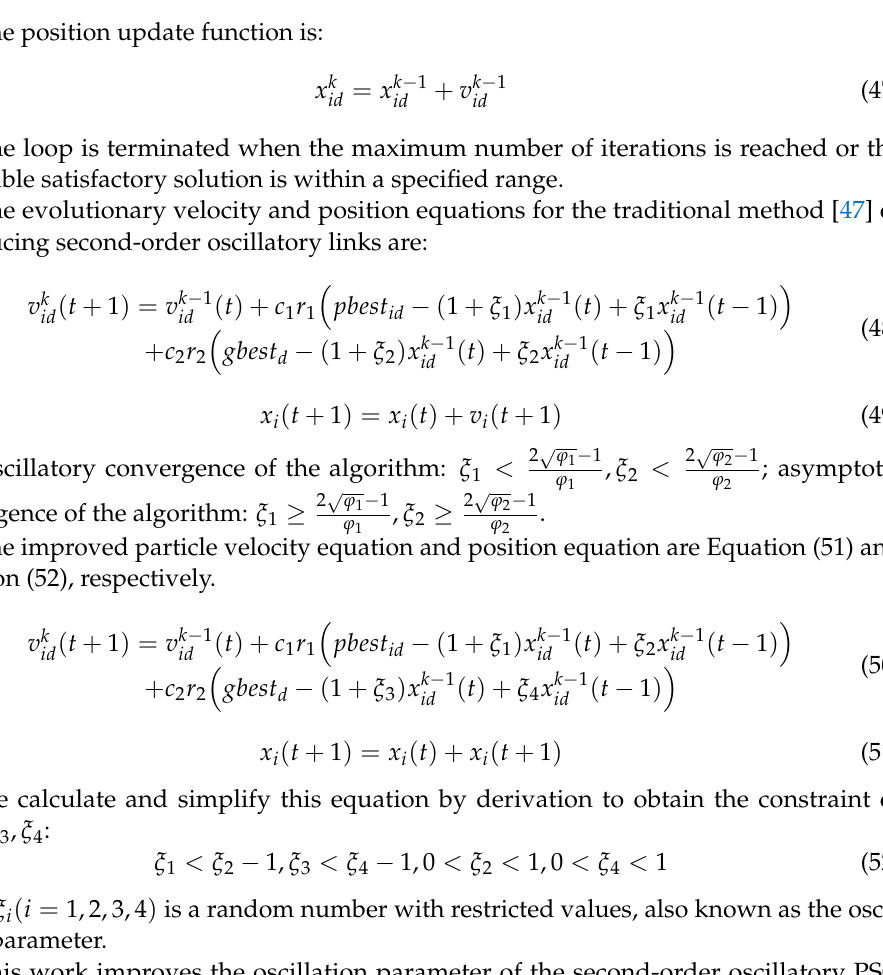
Figure 14. Particle swarm algorithm vector demonstration map.